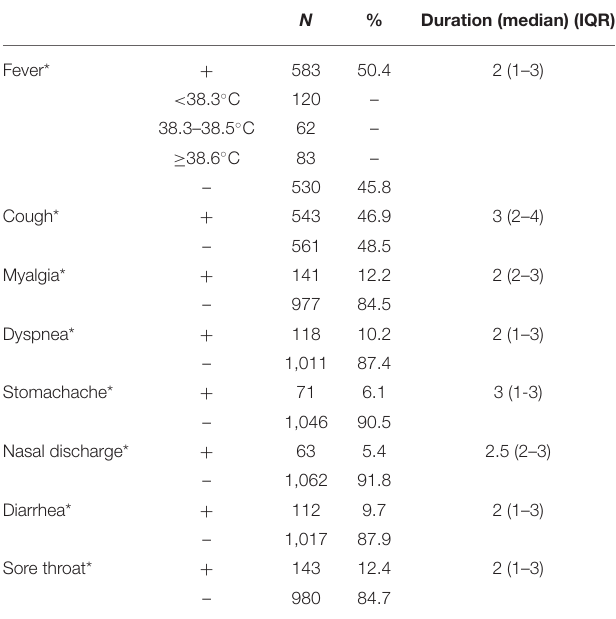
higher CRP levels than those who were asymptomatic ( p < 0.01) ( Table 5 ). Alanine transaminase (ALT) level of 52 cases was high among the total cases (5.5%) as well as of 43 cases (5.8%) of